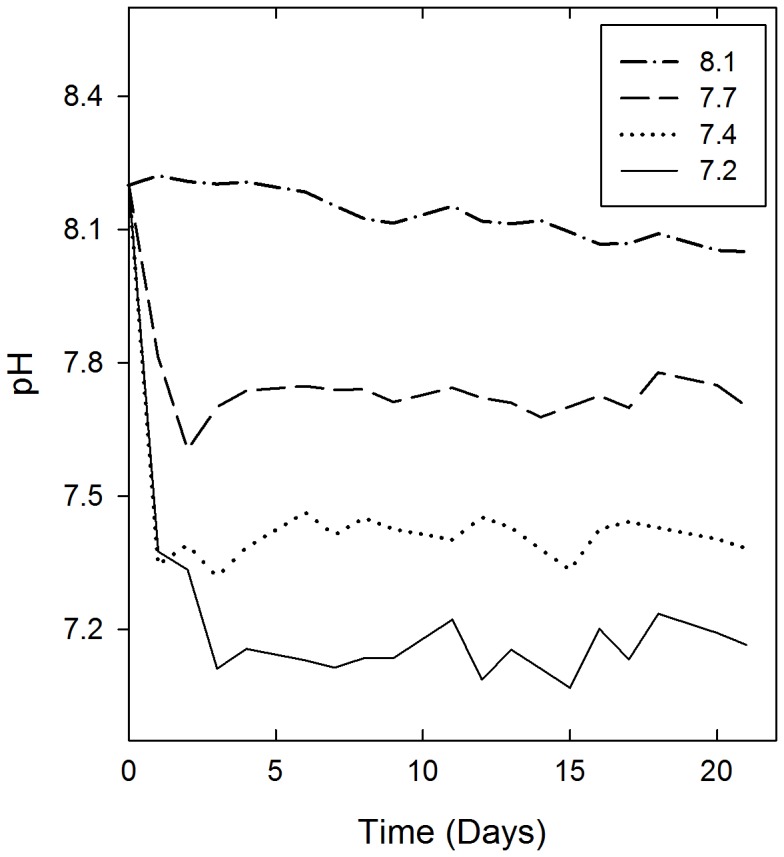
Mean pH levels during the experiment.Measured from all replicate bottles (n = 5) in each treatment. For clarity SD are not shown.